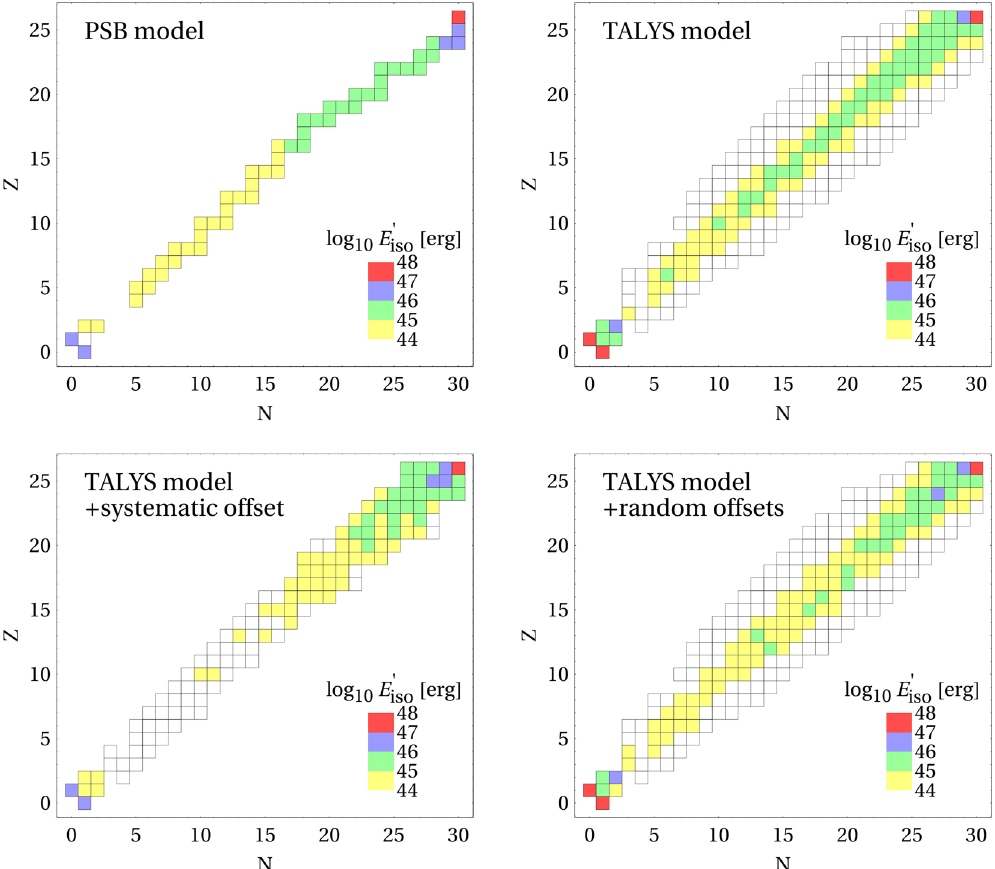
Figure 3. Disintegration of 56 Fe in a shell of a GRB, where the population of isotopes (in terms of the total energy per isotope and collision in the shock rest frame) is shown. The colors refer to the energy in the range indicated in the legend (between lower and upper shown value), and white boxes refer to energies below 10 44 erg. The upper panels correspond to the PSB 20 (left) and TALYS 22 (right) (and CRPropa2 24 for the lighter elements) models. The lower panels correspond to the TALYS model for different systematics assumptions (see 11 52 , Γ = 300 , t = 0.01 s, z = 2, and  E 10 GeV text for details). The GRB parameters are = γ L 10 erg/s v Fe, max ,iso (in the observer’s frame) for an E − 2 injection